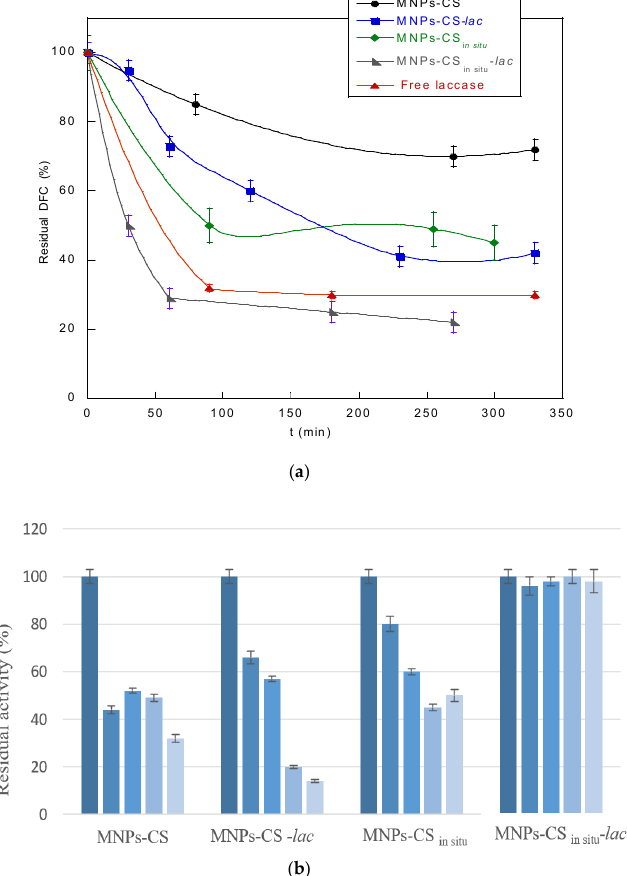
Figure 9. Residual percentage of diclofenac (DFC) after treatment with the developed magnetic systems and free laccase ( a ); reuse cycles in DFC removal by the magnetic systems ( b ).